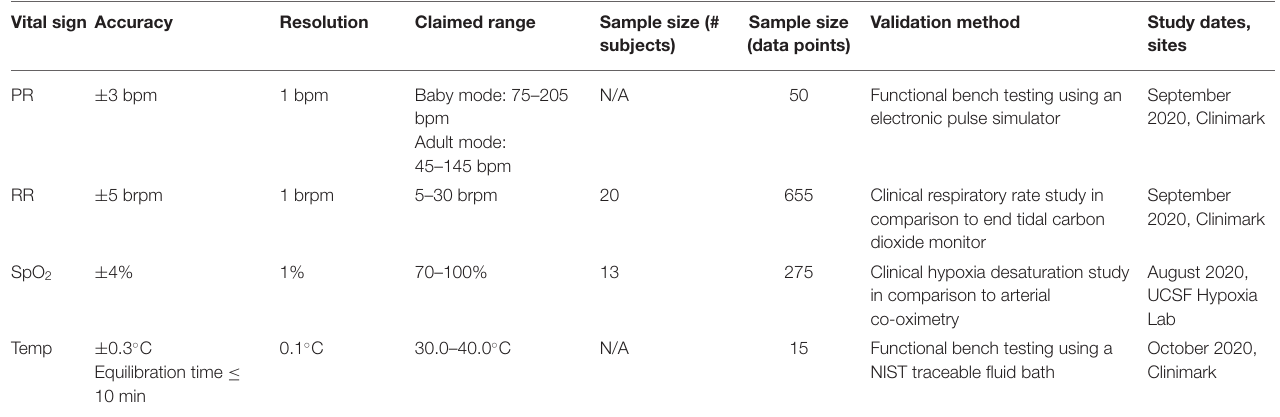
TABLE 1 | Summary of clinical validation study